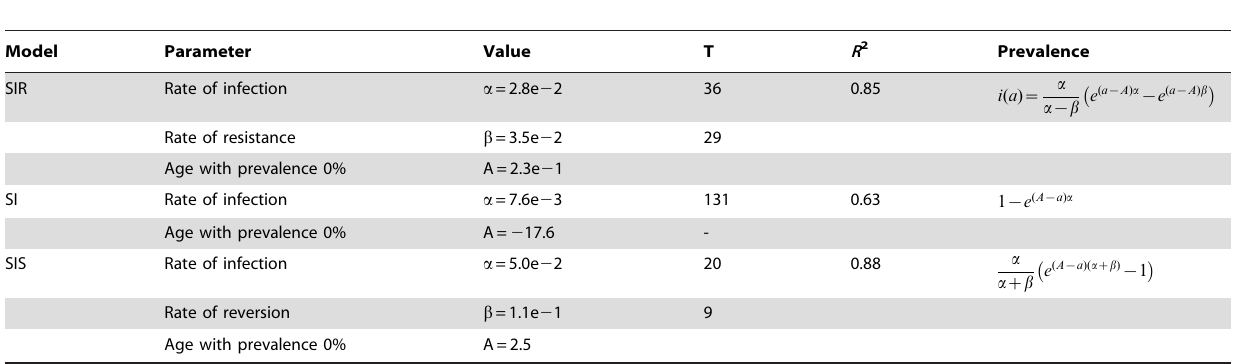
Table 4. Transition rates ( a , b ), age in months with seroprevalence 0% (A), average time in preceding state in months (T), model fit ( R 2 ), and prevalence equation for SIR, SI, and SIS-model fitted to the age-related T. gondii seroprevalence in 932 wild boar.